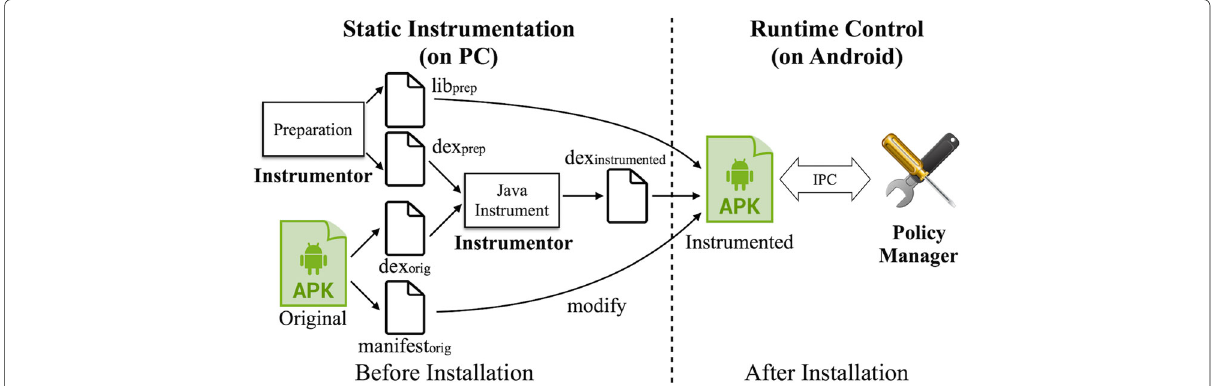
Fig. 2 Whole process of Sensor Guardian. The whole process of Sensor Guardian’s static instrumentation and runtime control